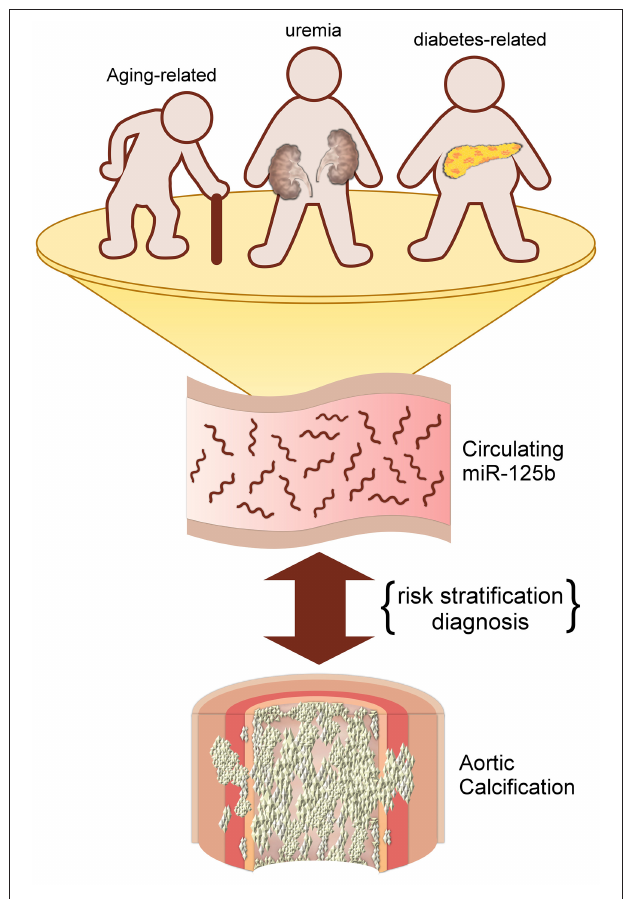
FIGURE 2 | An illustrative diagram depicting the potential utility of circulating miR-125b for predicting aortic calcification/vascular calcification of different